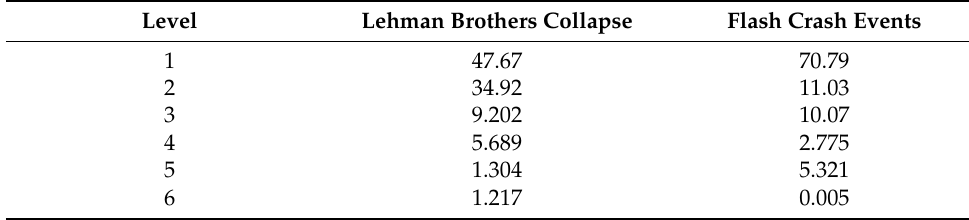
Table 12. Total energy for UTX stock market data.